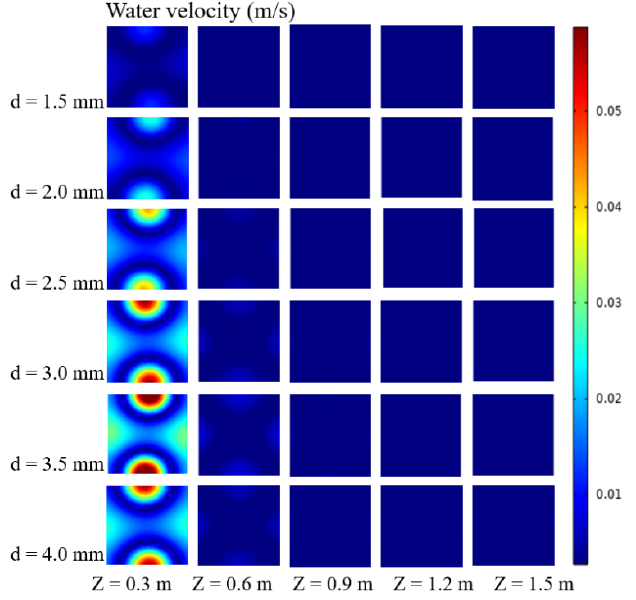
Figure 7. Water velocity variation along the horizontal direction at different orifice diameters.